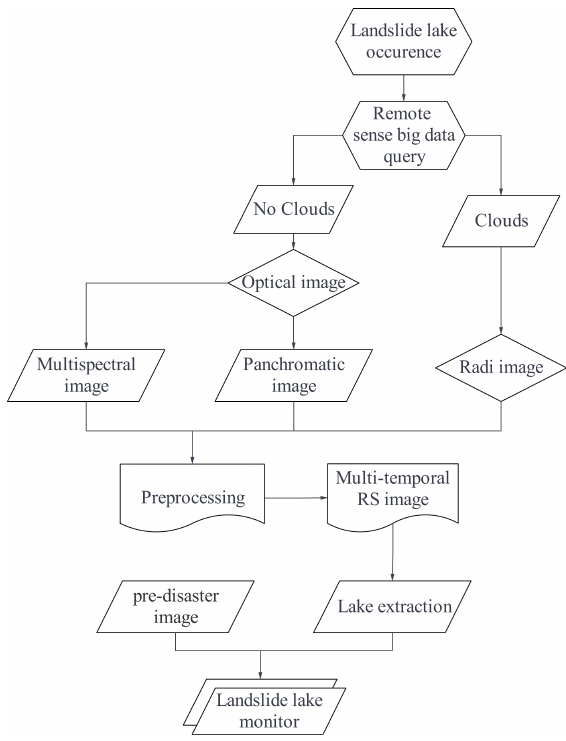
Figure 3. Flow chart of technology System